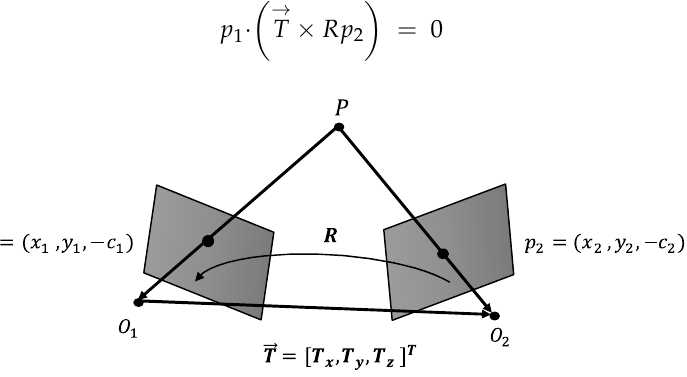
Figure 1. The co-planarity model relating stereo-images.